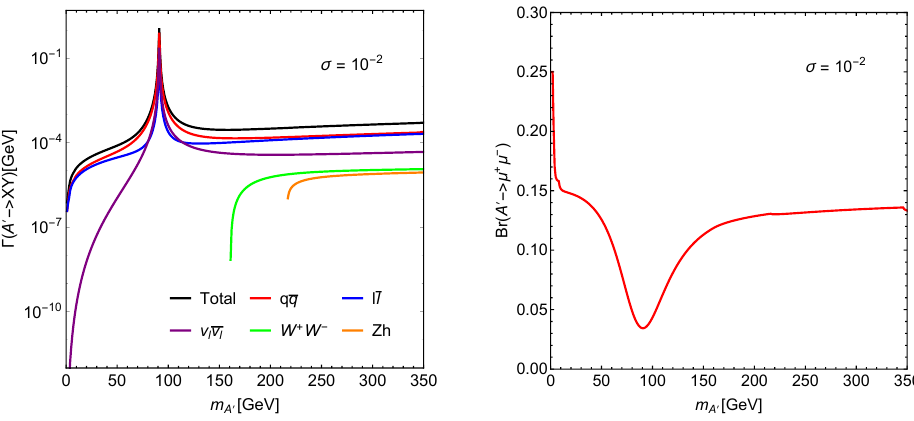
Figure 2 . Total and partial widths of A 0 (left) and the braching ratio of A 0 ! (cid:22) + (cid:22) (cid:0) (right) with (cid:27) = 10 (cid:0) 2